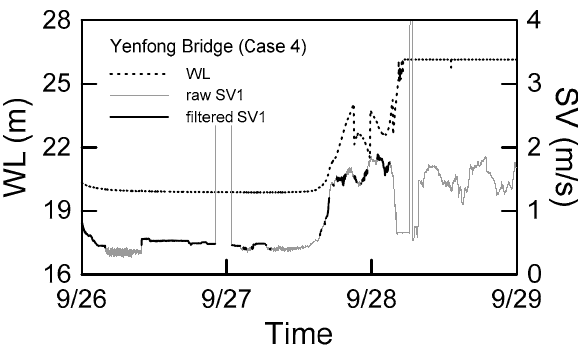
Figure 12. Filtered time series of SV at Yenfong Bridge from September 27th to 29th, 2016.